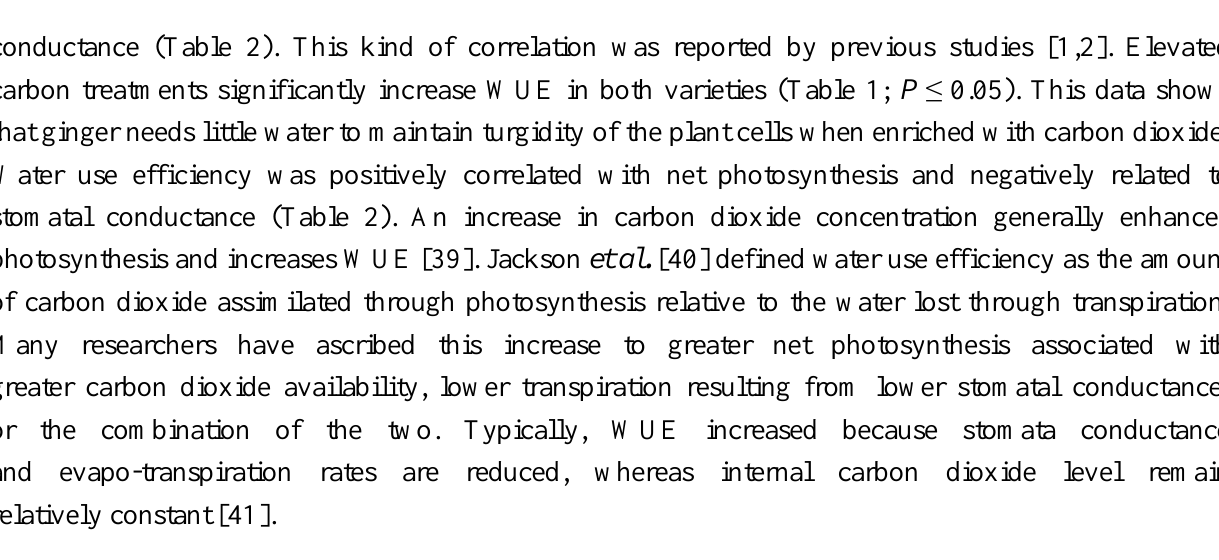
concentration on biomass, photosynthesis rate and stomata 2